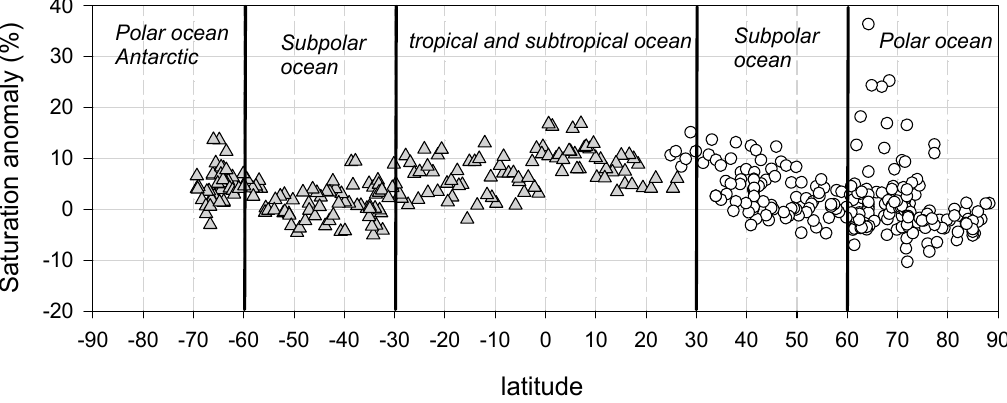
Figure 5. Saturation Anomaly values along the cruise tracks of the 4th Chinese National Arctic Research Expedition (empty circles) and the 27th Chinese Antarctic Research Expedition (gray triangles).